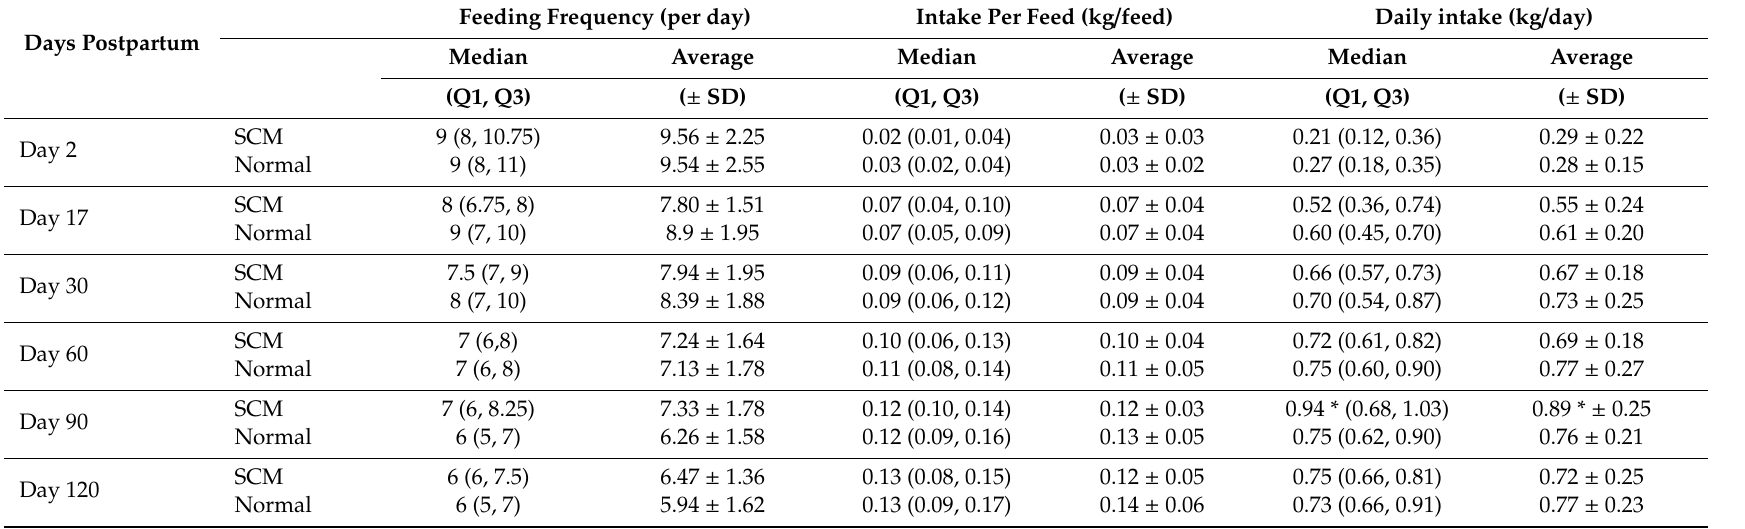
Table 4. Pattern of infants born to SCM and normal mothers at each time